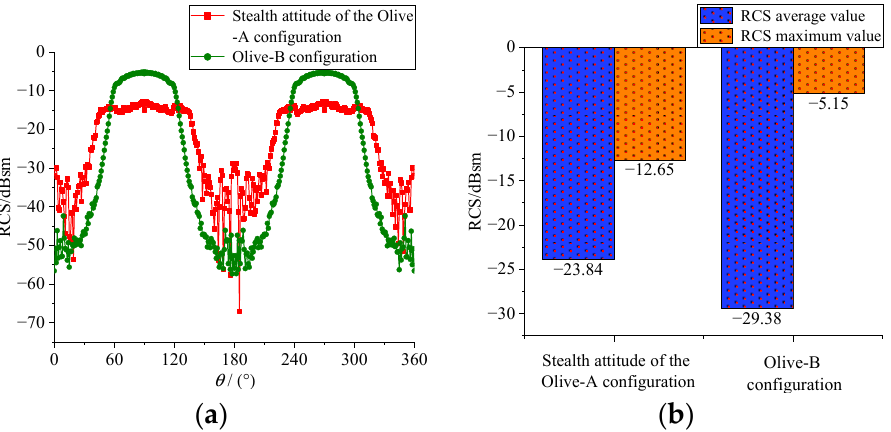
Figure 6. RCS comparison of the stealth attitude of the Olive-A and the Olive-B. ( a ) Comparison of RCS distribution. ( b ) Comparison of RCS mean and maximum values.